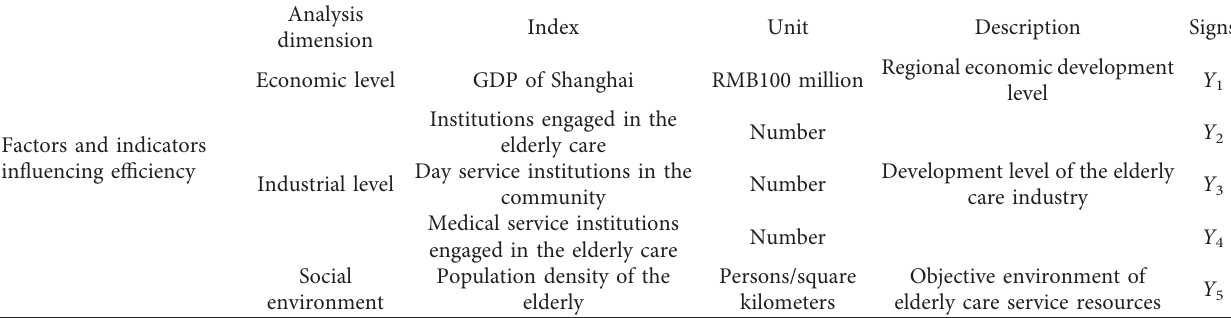
Table 4: Factors influencing efficiency.